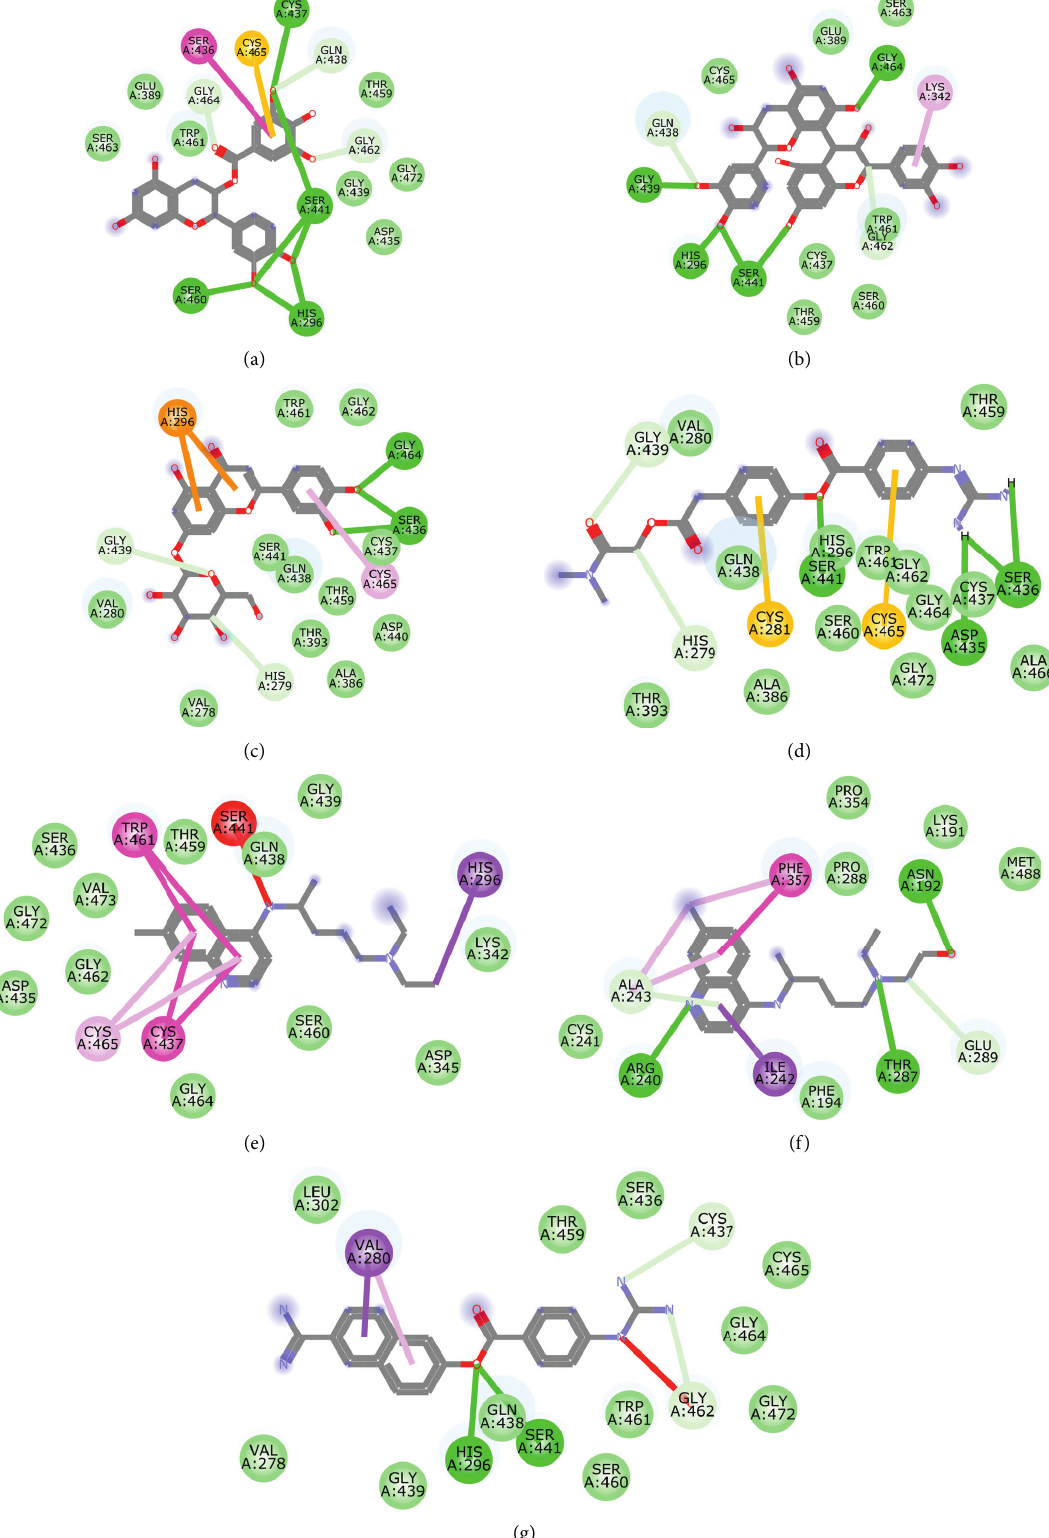
Figure 15: 2D representation of (a) 3-galloylcatechin, (b) proanthocyanidin B1, (c) luteolin 7-galactoside, (d) camostat, (e) chloroquine, (f) hydroxychloroquine, and (g) nafamostat in the binding pocket of TMPRSS2. Hydrogen, carbon-hydrogen, and π bonds are depicted as green, light blue, and any other coloured (purple, magenta, orange, turquoise blue, pink, and yellow) broken lines, while Van der Waal interactions appear as light green